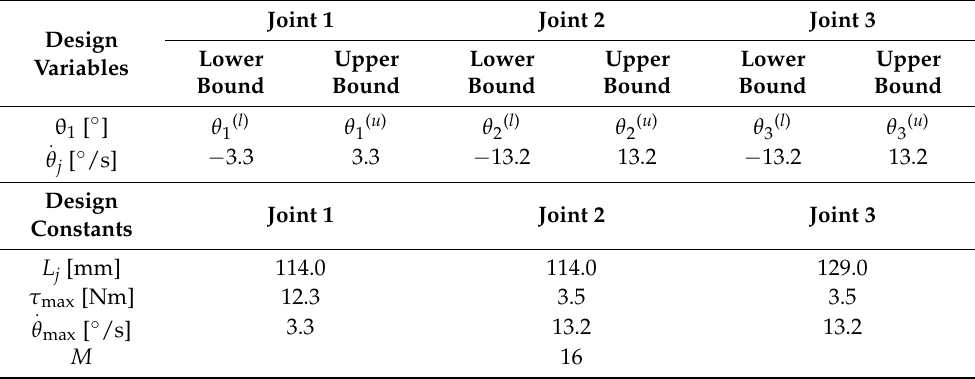
Table 3. Design and control parameters of the